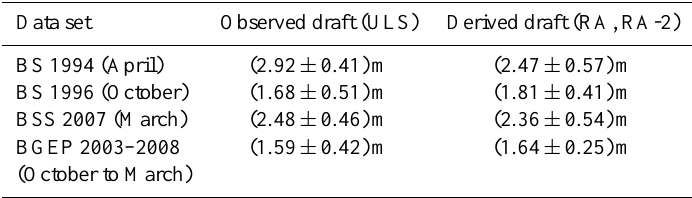
Table 4. Summary of observed and computed sea ice draft values using standard settings and W99 snow parameters; given are mean values plus/minus one standard deviation. The respective month the data set is valid for is given in the first column. See Table 1 for data set acronyms.